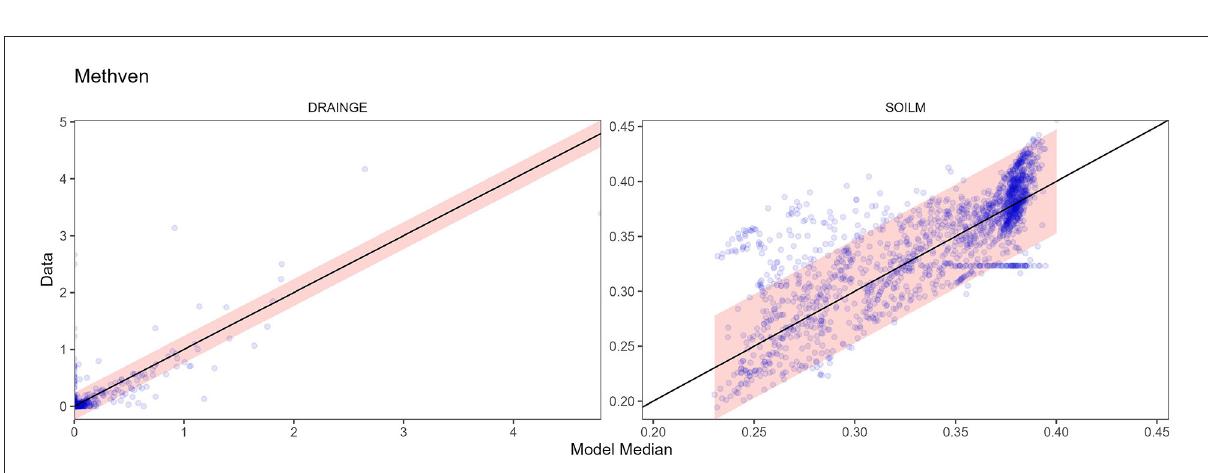
from the data. Correlations between the parameters can also be checked using a “pairs” plot (see Figure A1). The median parameter values are shown in Figure 8 as vertical lines, whereas the maximum a posteriori (MAP) parameter set is shown as blue dots. Although the MAP parameter set is technically the “best fit”, in practice it is much better to use the entire posterior distribution to represent the model calibration. The MAP parameter set may be somewhat different to the median posterior value, and model predictions based on the MAP